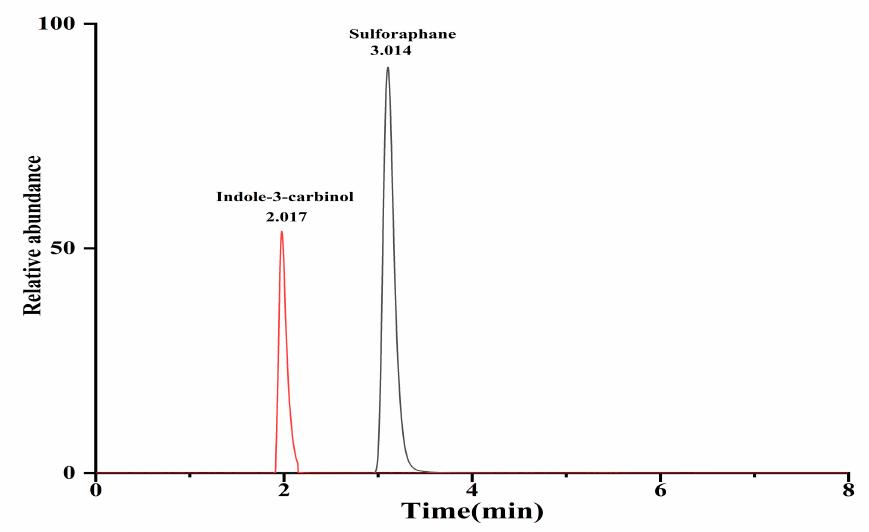
Figure 4. UHPLC-MS / MS chromatograms (MRM) of sulforaphane and indole-3-carbinol in rapeseed samples at 10 and 25 µ g / kg, respectively. Table 3. Quantity of the detected sulforaphane and indole-3-carbinol in rapeseed samples a ( µ g / kg).